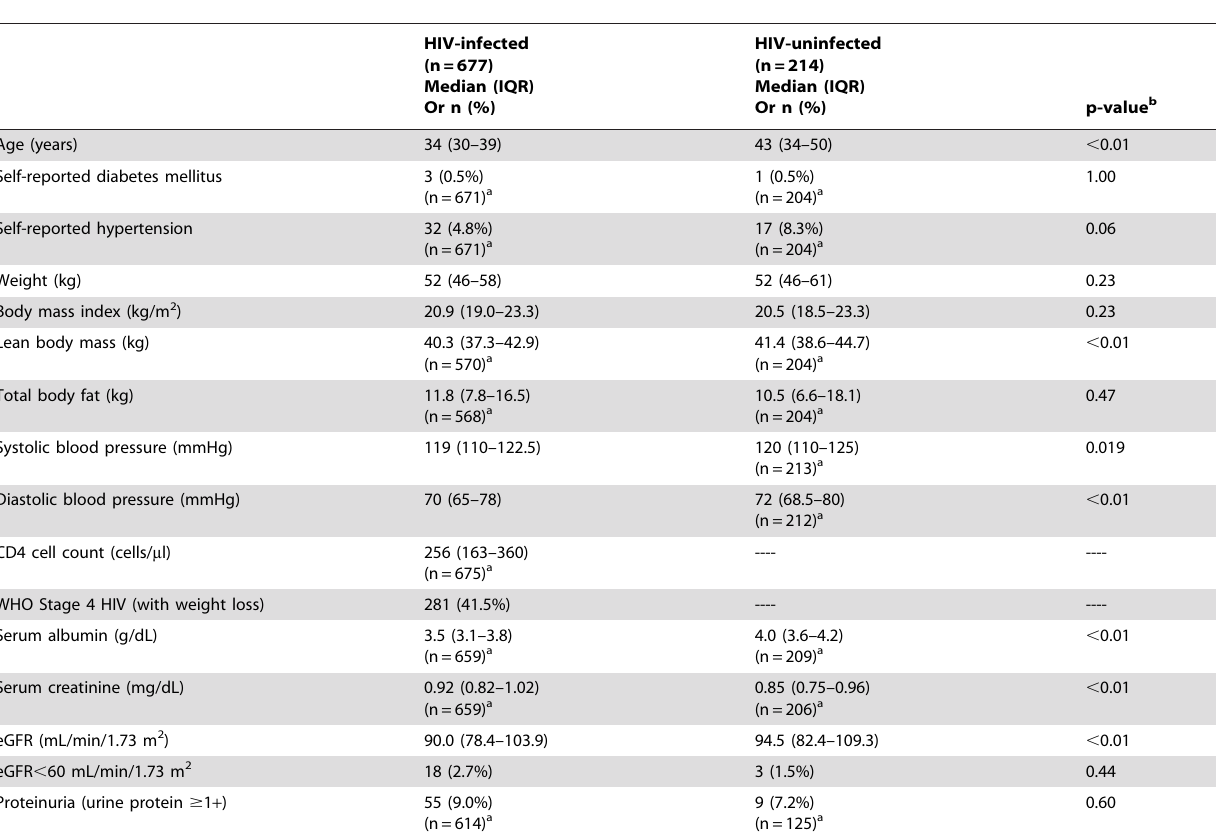
Table 1. Clinical and demographic variables stratified by HIV